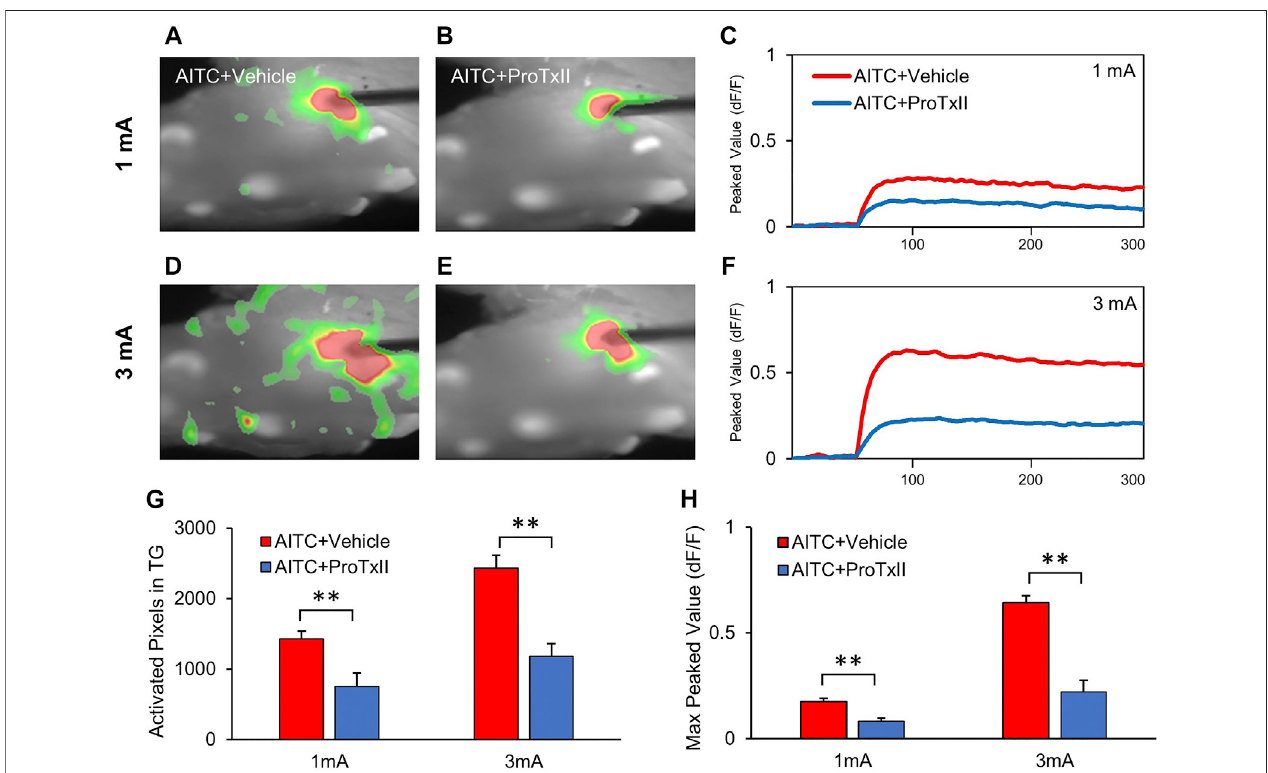
FIGURE5 | Reduced neuronal activitiesin TGbyapplicationof theProTxII. (A,B) Comparison ofoptical signals in theinhibition ofNav1.7 activation at 1 mA. (C,D) Comparison of optical signal changes after ProTxII at 3 mA. Optical signals showed that the expanded and propagated neuronal activities were reduced after ProTxII. (E,F) Temporalpeakvaluechangesat1and3 mA. (G) ComparisonoftheactivatedpixelsintheTGs. (H) ComparisonofthemaxpeakvaluesafterProTxII.Comparedto AITC + Vehicle, signi fi cantly redeced activated pixcels and peak activity were observed in AITC + ProTxII group (Error bars represent SEM; ** p < 0.01).